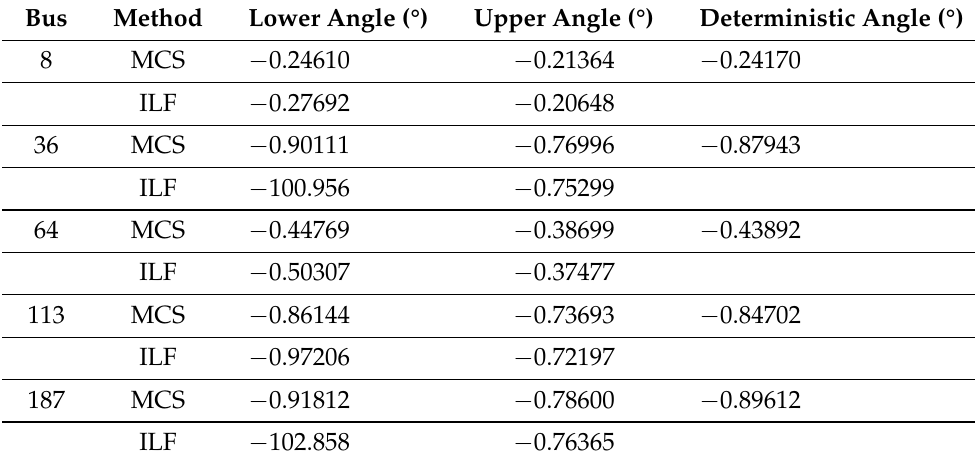
Table 5. Phase Angle—192-bus Brazilian distribution network.